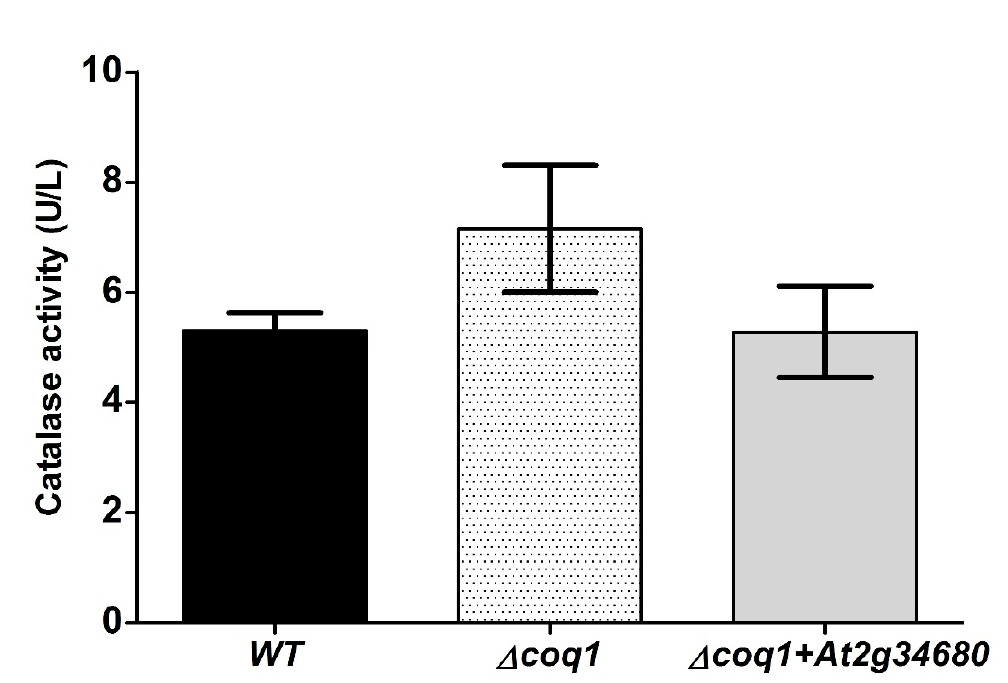
Figure 7. Change in UQ side chain length does not alter transcriptional regulation of the oxidative stress response. Catalase activity (units/liter) measured 60 min after addition of sub-lethal farnesol (20 µM). Average of 3 replicates.